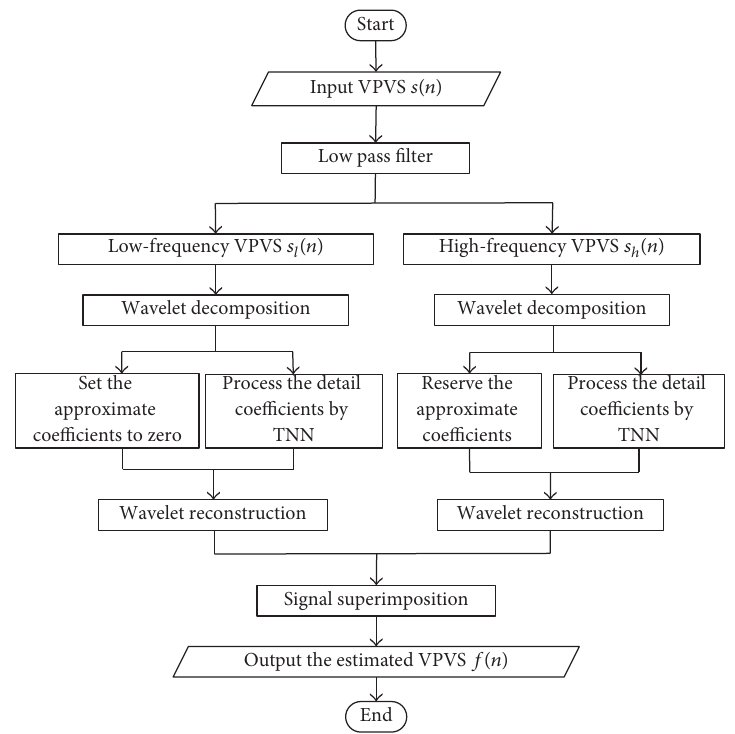
Figure 10: Flow chart of proposed VPVS denoising method.